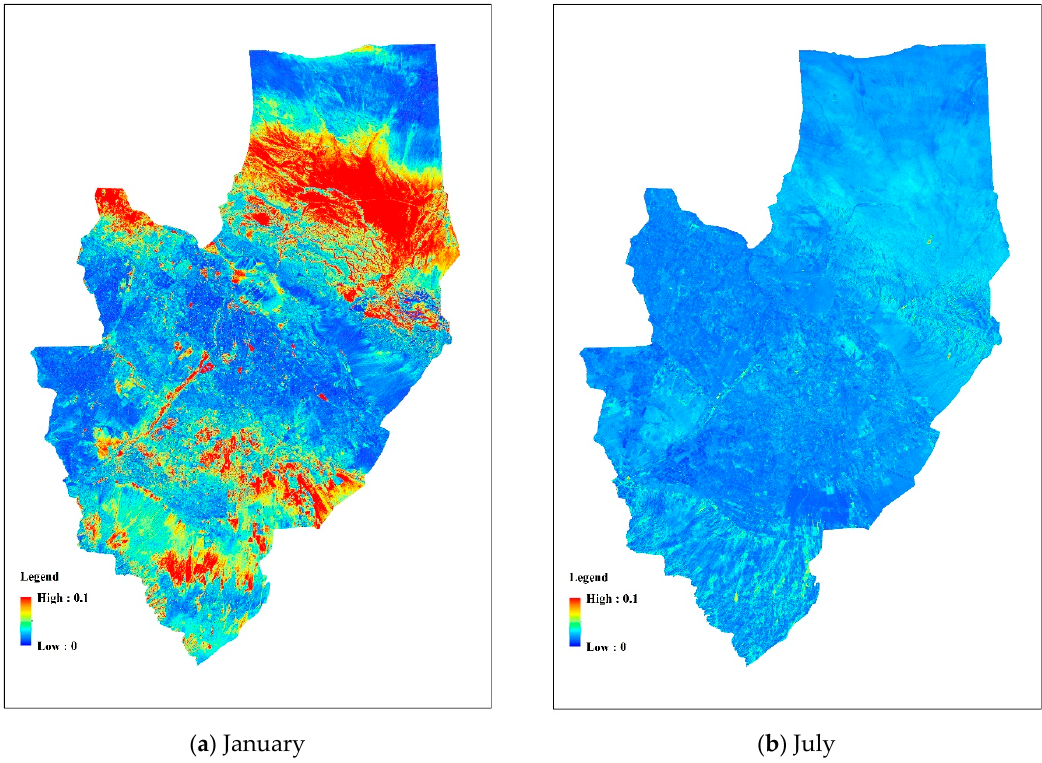
Figure 7. Spatial distribution of SD of surface albedo in ( a ) January and ( b ) July. Table 5. Average and SD of surface albedo of different land cover types in January and July.